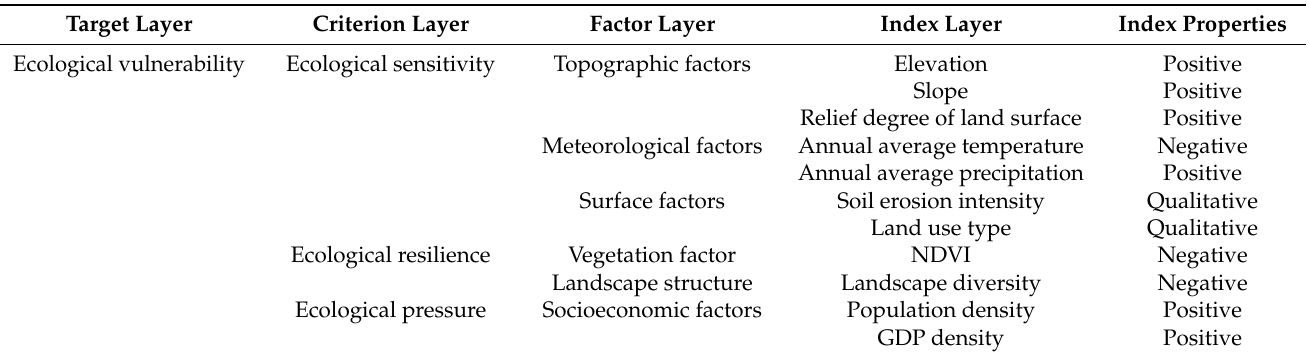
Table 1. Assessment index system of ecological